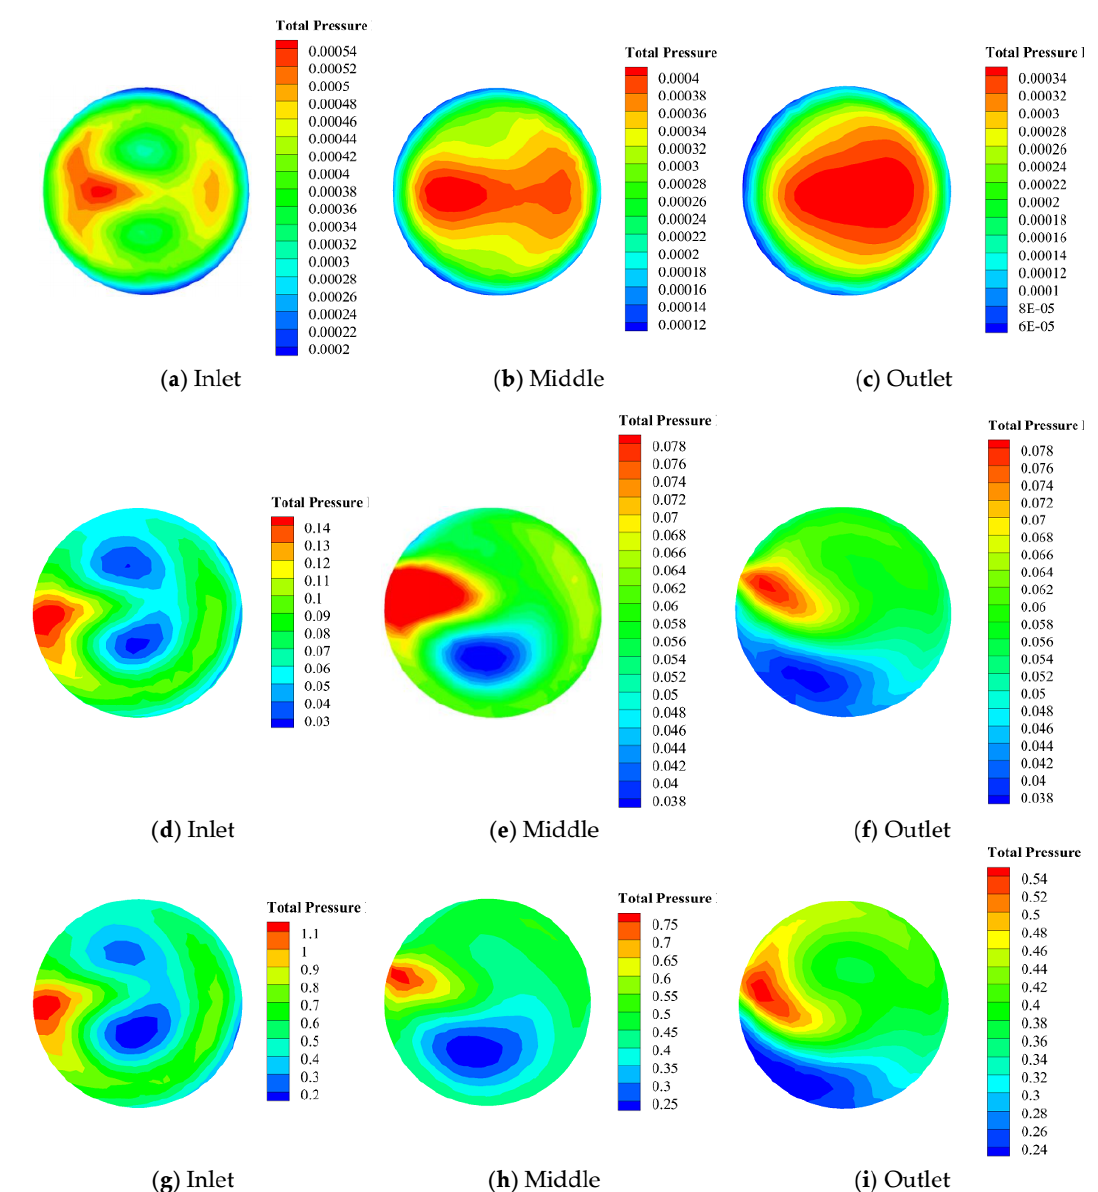
Figure 20. Distribution of total pressure in different planes within wind tower’s column for: ( a – c ) 0.1 m/s; ( d – f ) 1.5 m/s; and ( g – i ) 4